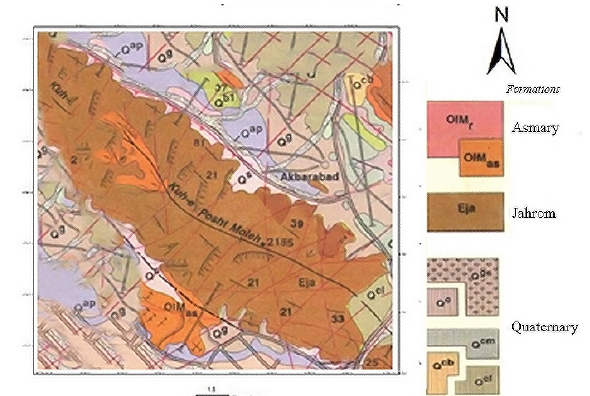
Fiigure 2. Geological map of Posht Moleh Mountain (Baba Kouhi).